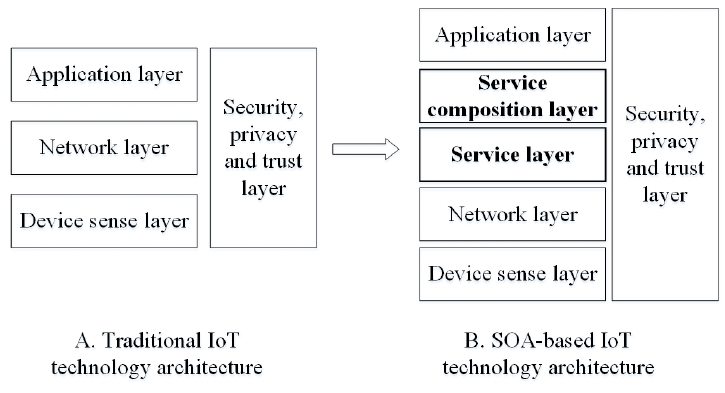
Figure 1. Internet of Things (IoT) technology